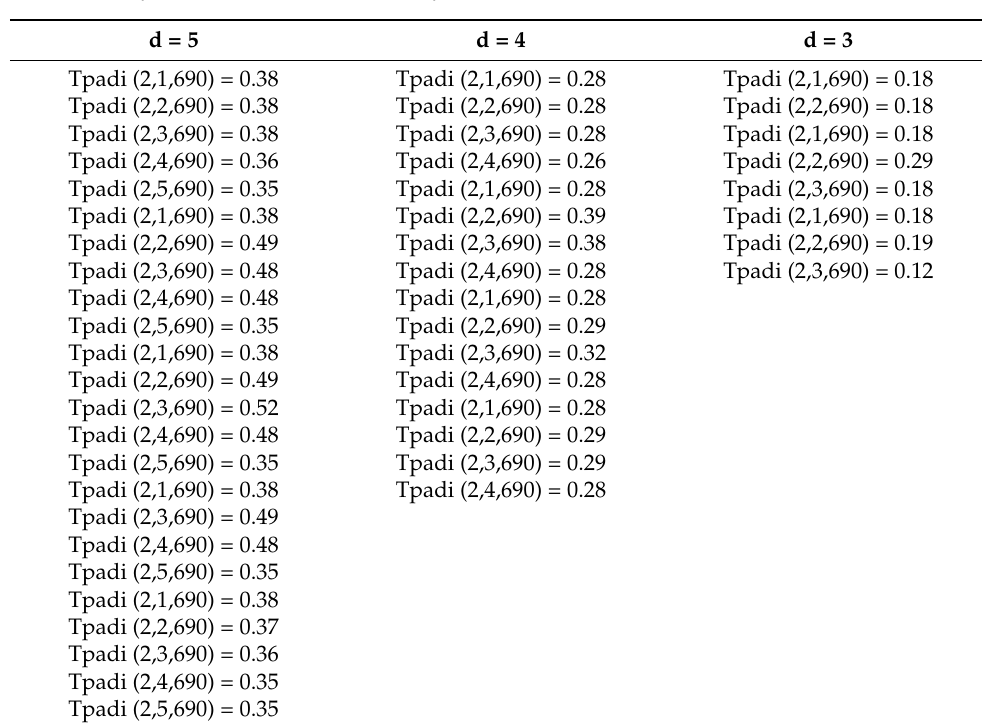
Figure 3. The system is in the process of reaching a stable state (the temperature and scale of the object are indicated in conventional units). Table 1. Study of the bottom of the electrolysis